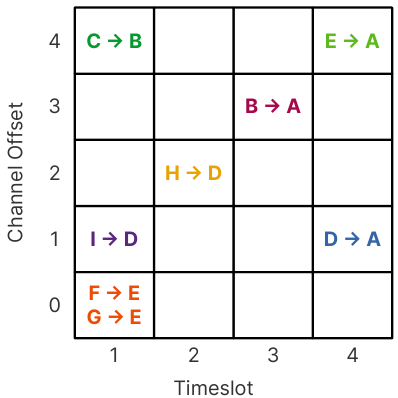
Figure 2. Example of how a many-to-one schedule on a five-channel deployment can be constructed using the RPL topology defined in Figure 1. The channel offset translates to the radio frequency used for the transmission of the frame, and the timeslot is the time window assigned to each node to send information to the